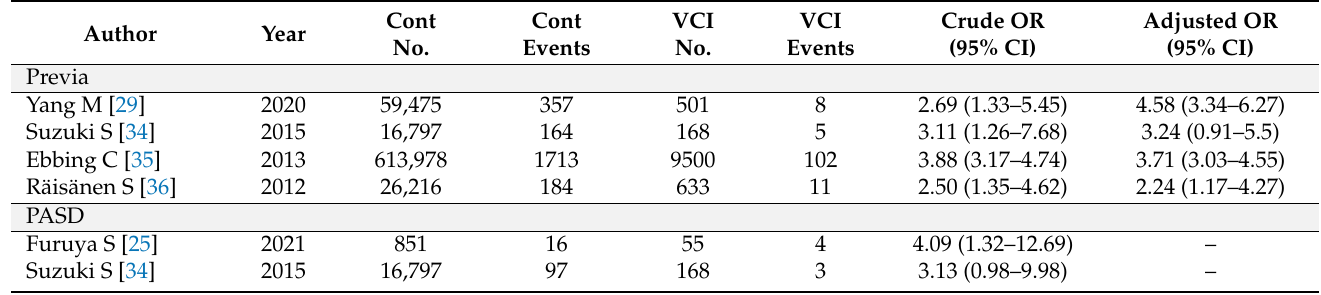
Table 4. Effect of VCI on the rate of abnormal placentation and malpresentation.